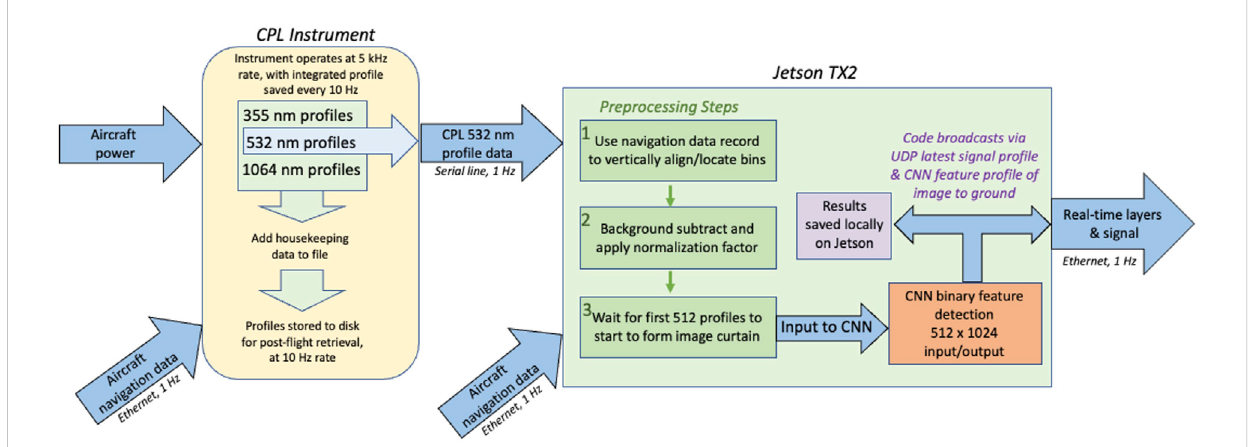
FIGURE 1 Overview ofCPL data collection,data interfaces, and Jetson TX2processing fl ow. Owing to bandwidth limitations onthe aircraftdata network, only one (of ten) CPL pro fi les per second is transmitted to the TX2 board.